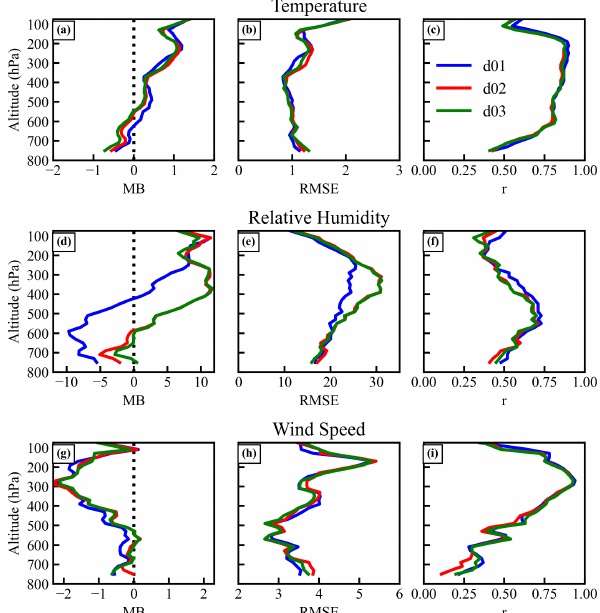
Figure 5. The vertical profiles of the mean bias (MB), root mean square error (RMSE), and correlation coefficient ( r ) for tempera- ture, relative humidity, and wind speed in the different domains d01 (blue), d02 (red), and d03